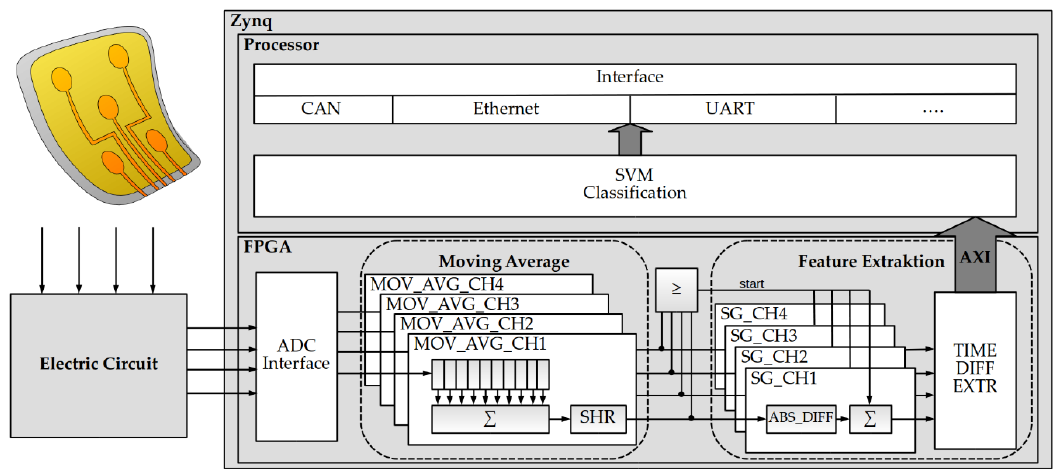
Figure 7. Novel system architecture for real ‐ time processing on the basis of Zynq SoC (XC7Z010) with complete process flow.